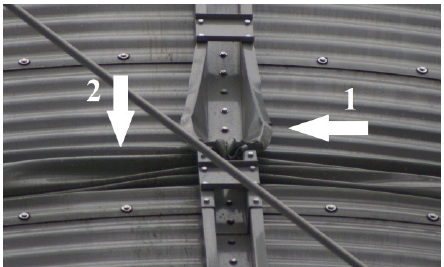
Fig. 10. Most characteristic damage: 1 – damage to stringer; 2 – damage to sheathing (compression of